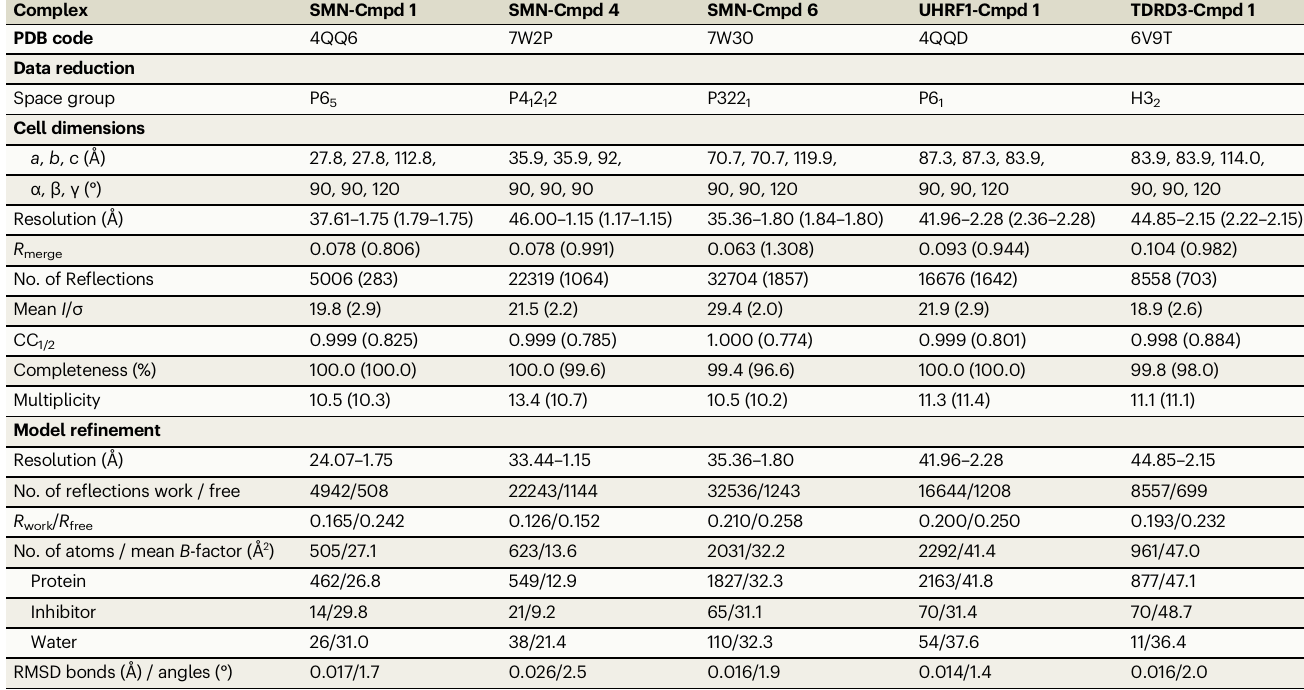
Table 1 | Data collection and re fi nement